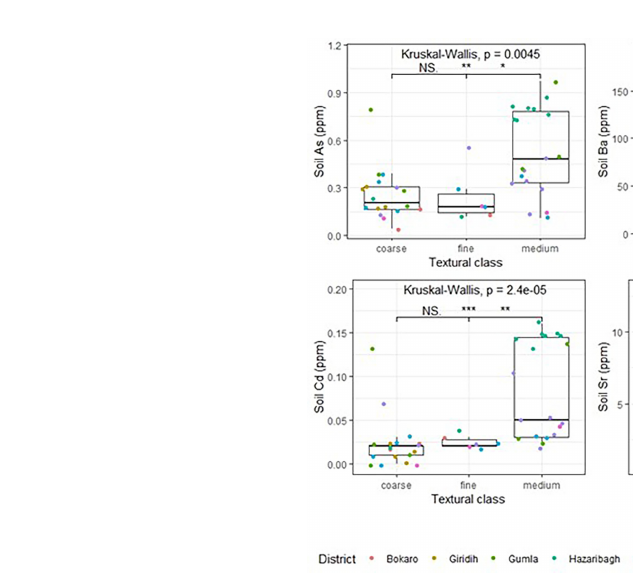
FIGURE 5 | Soil toxin distribution among textural group. NS: not signi fi cant; * signi fi cant at the 0.05 signi fi cance level; ** signi fi cant at the 0.01 signi fi cance level; *** signi fi cant at the 0.001 signi fi cance level.